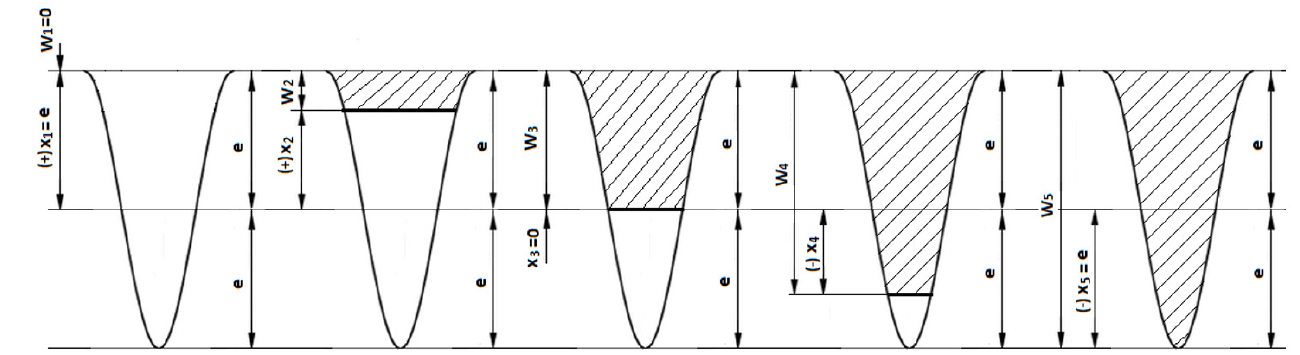
Figure 5. Graphical interpretation of quantities: w —measurable eccentricity, x —support displacement, e —eccentricity.